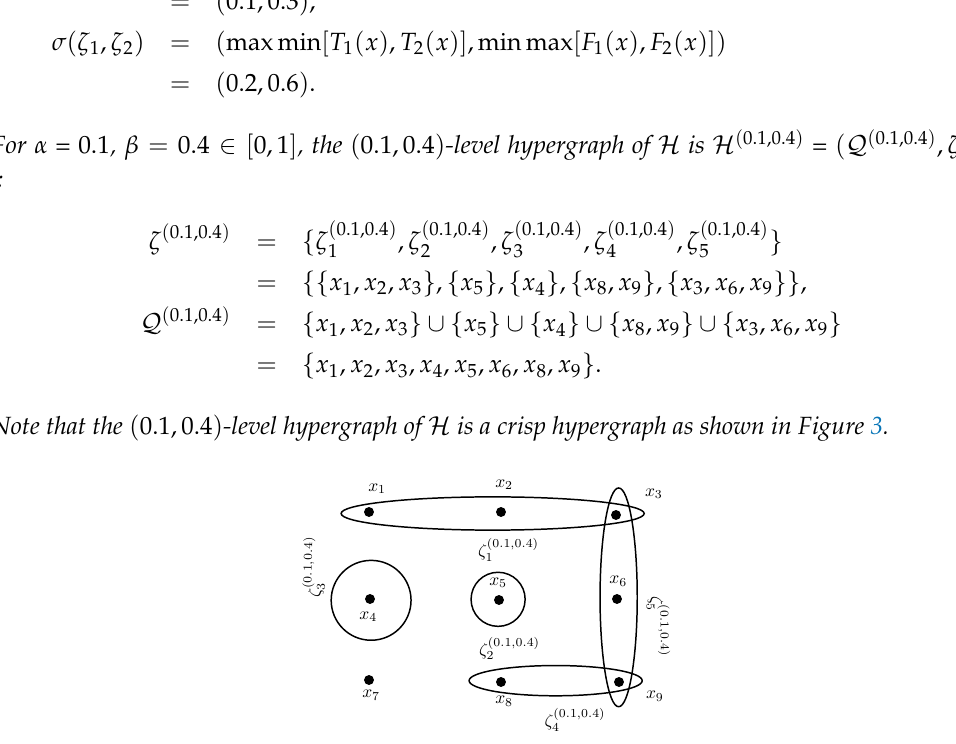
Figure 3. The ( 0.1,0.4 ) -level hypergraph of